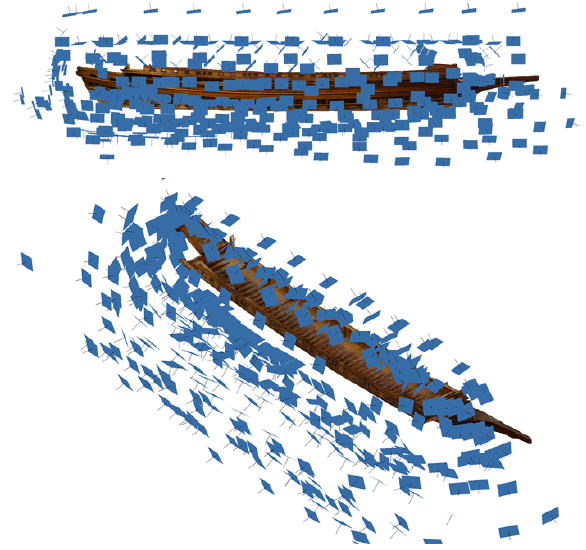
Figure 4. The photogrammetric model of the maquette